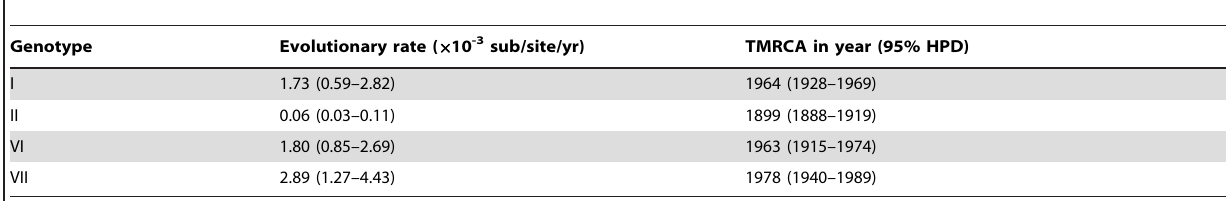
Estimates are based on the relaxed clock with uncorrelated exponential distribution (UCED).